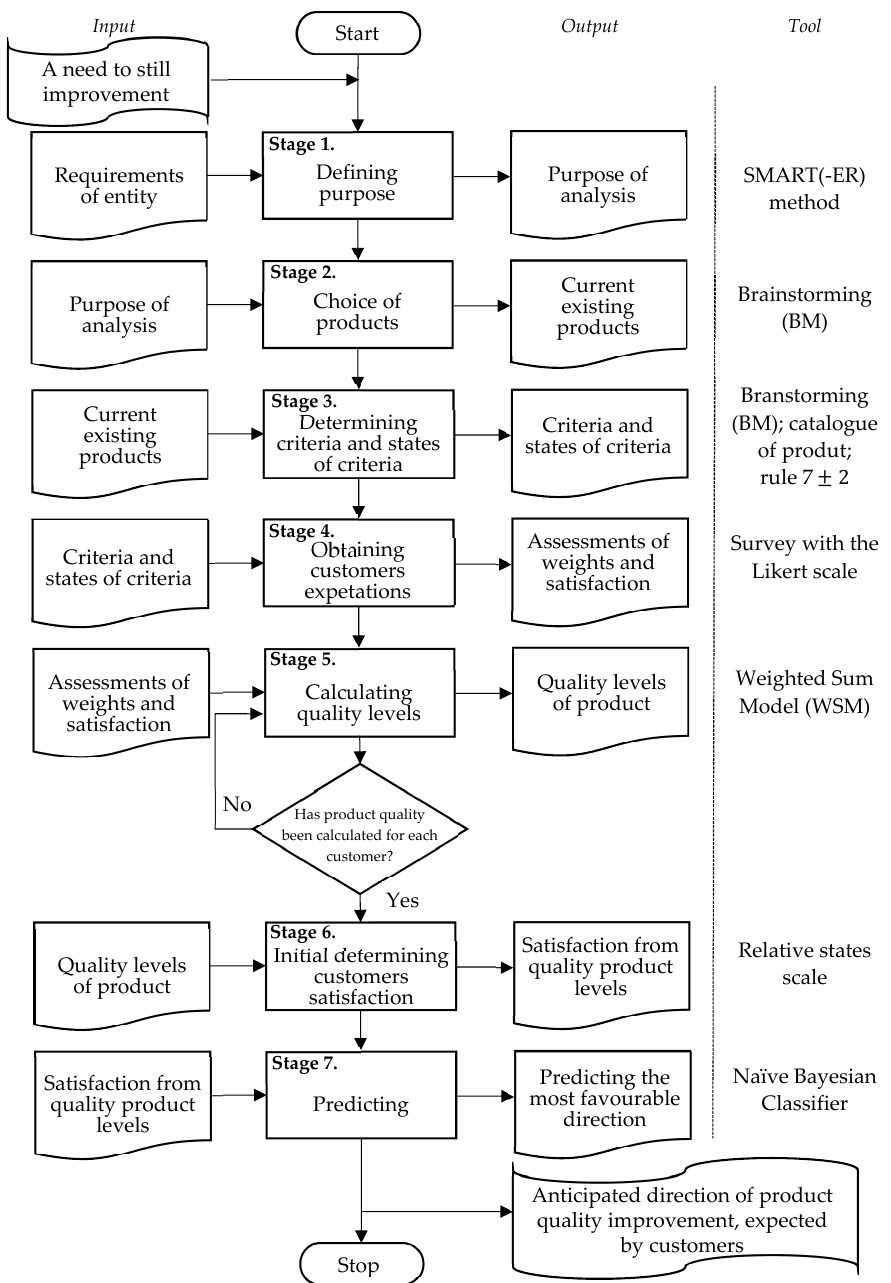
Figure 2. Universal model to predict expected direction of products quality improvement. Own study.